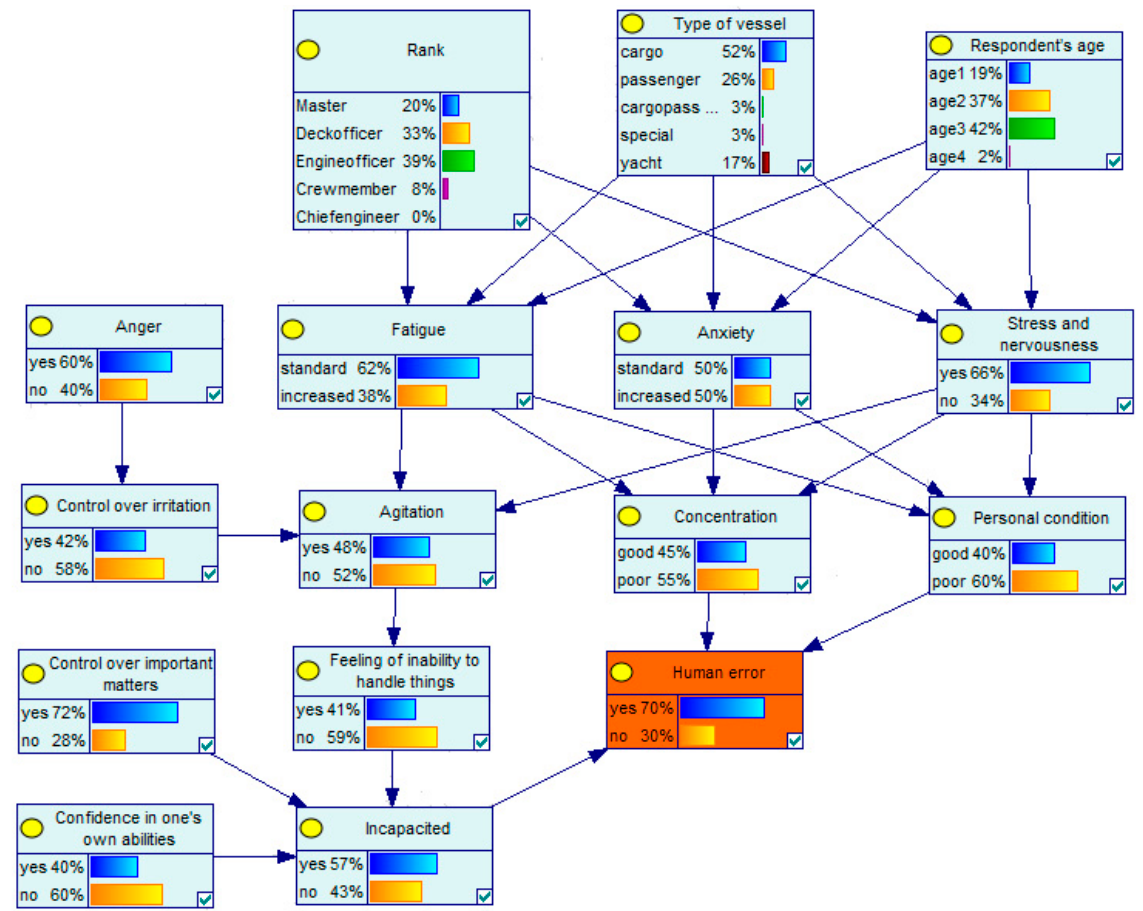
Figure 7. Quantitative model for human error (developed and tested using GeNIe/SMILE) (BayesFu- sion, Pittsburgh, PA, USA, 2020). Table 3. Values obtained through examination of sensitivity by selecting the variable Human error.